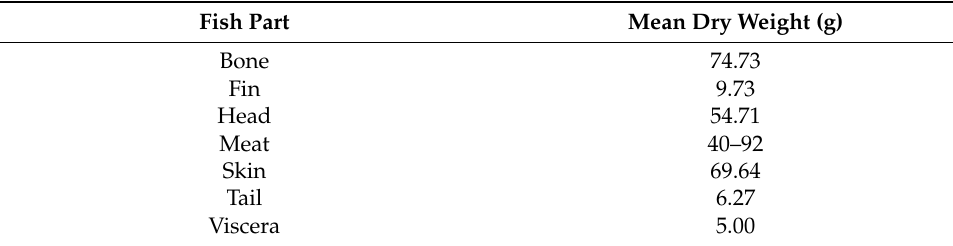
Figure 2. Di ff erent parts of Tilapia spp. Collected for HM analysis. Figure 2. Different parts of Tilapia spp. Collected for HM analysis. Table 1. The mean dry weight of fish parts, n = 77.